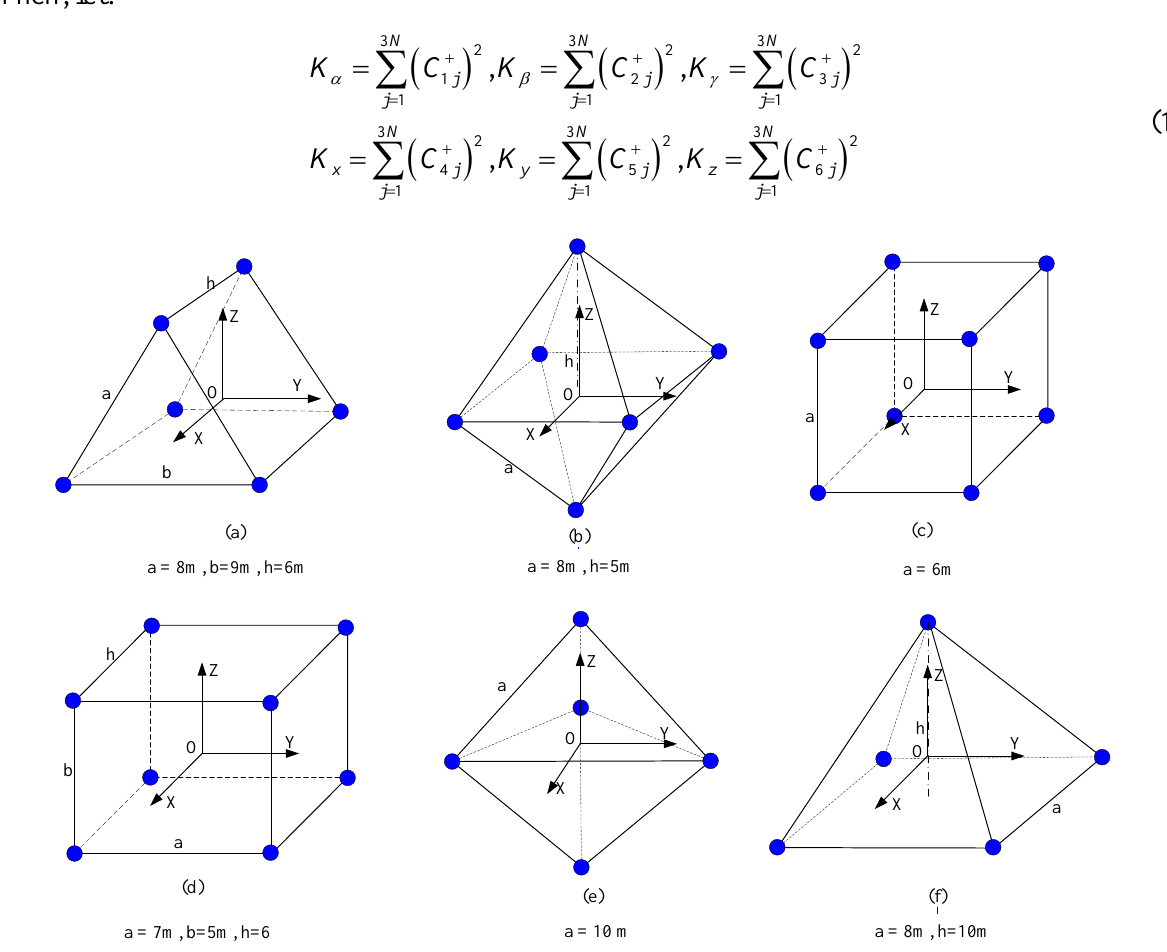
Figure 4. The geometric layouts of the ERS points. ( a ) Triangular prism layout; ( b ) Double rectangular pyramid layout; ( c ) Cube layout; ( d ) Cuboid layout; ( e ) Double triangular pyramid layout; ( f ) Rectangular pyramid